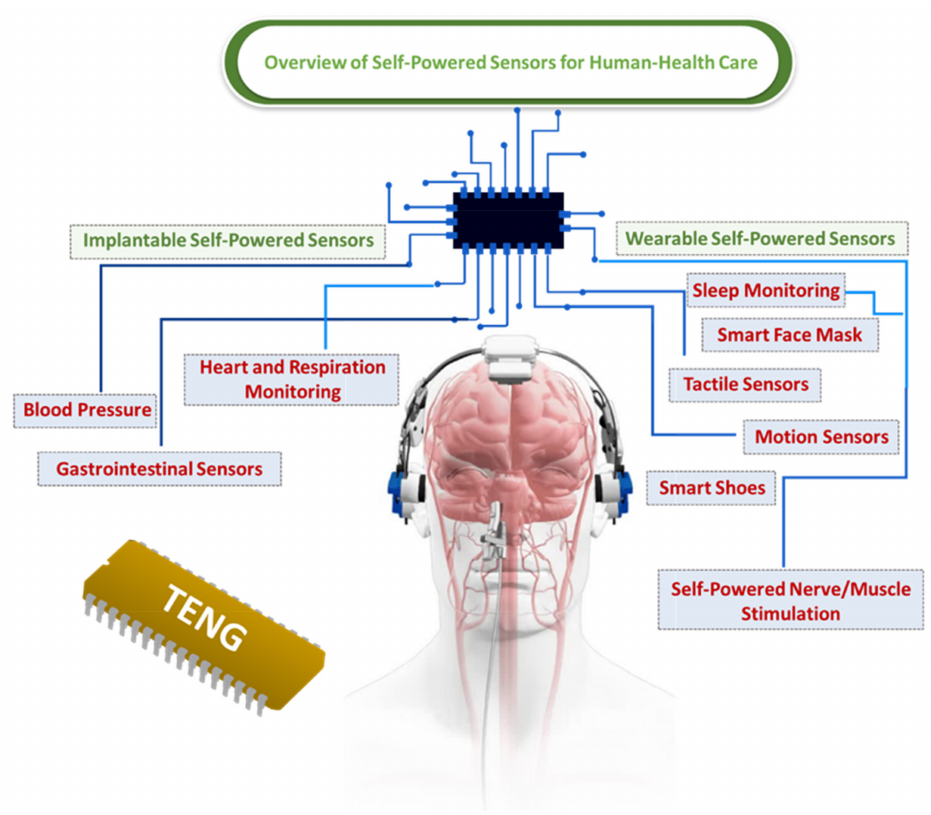
Figure 4. Overview of self-powered sensors for human health care